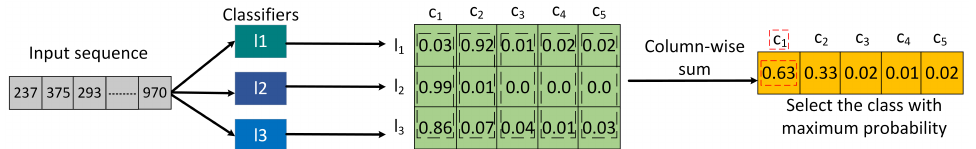
Figure 7. Example of a soft-level combination in which the average rule is